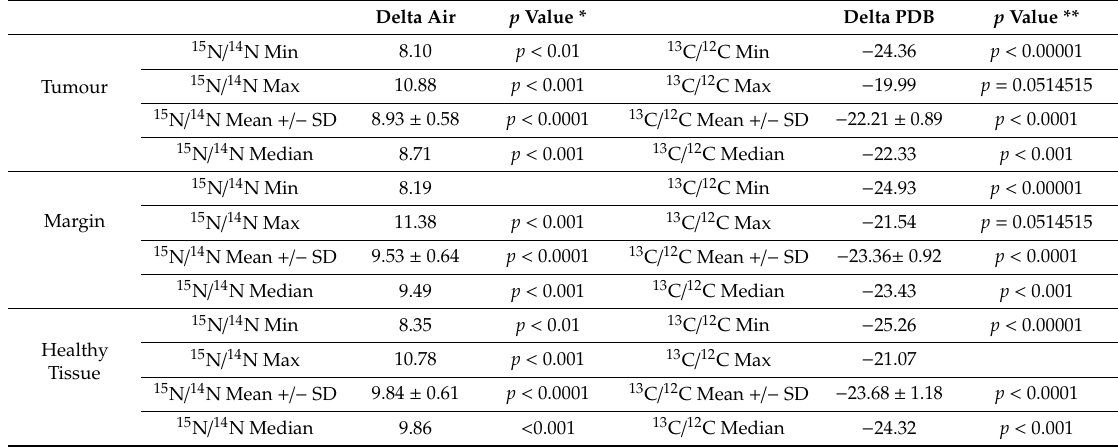
Table 3. Results of 15 N / 14 N and 13 C / 12 C isotope ratio